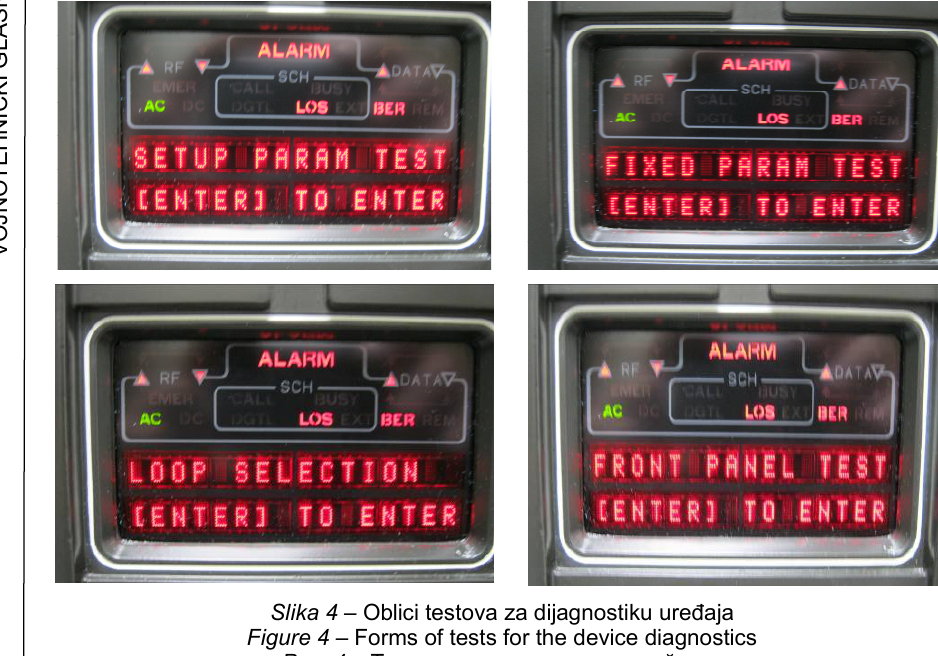
Figure 4 – Forms of tests for the device diagnostics Рис . 4 – Тесты по диагностике